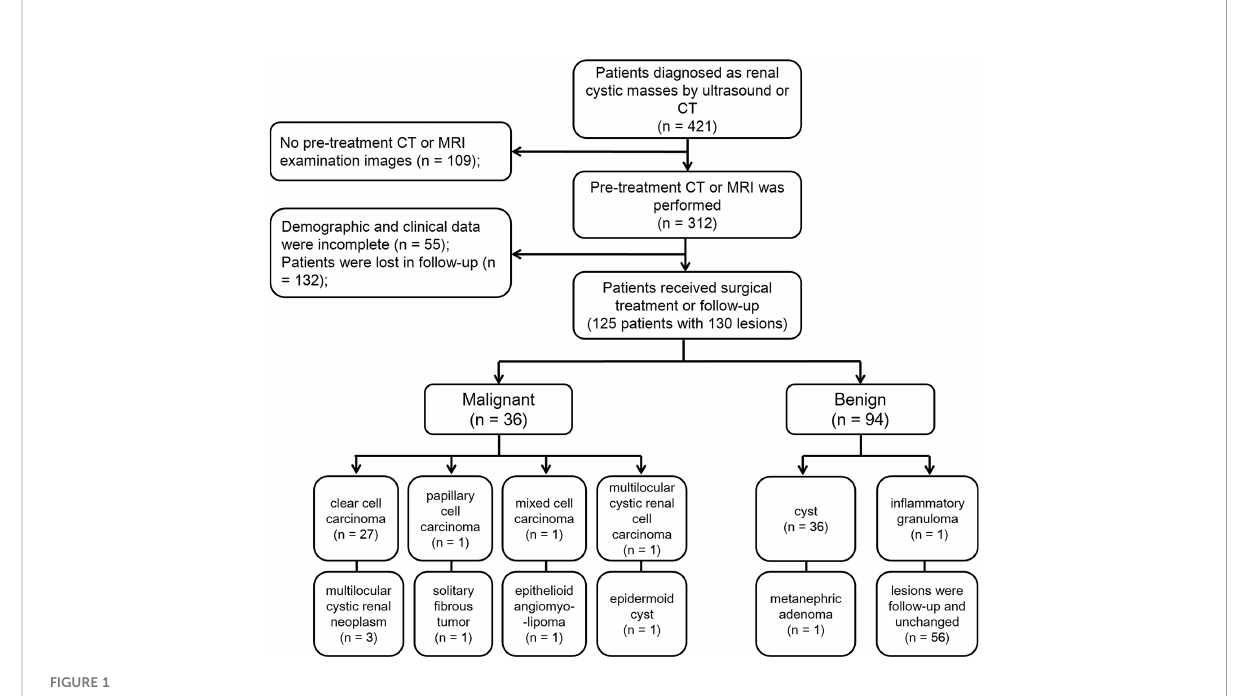
FIGURE 1 Flowchart of patient inclusion and